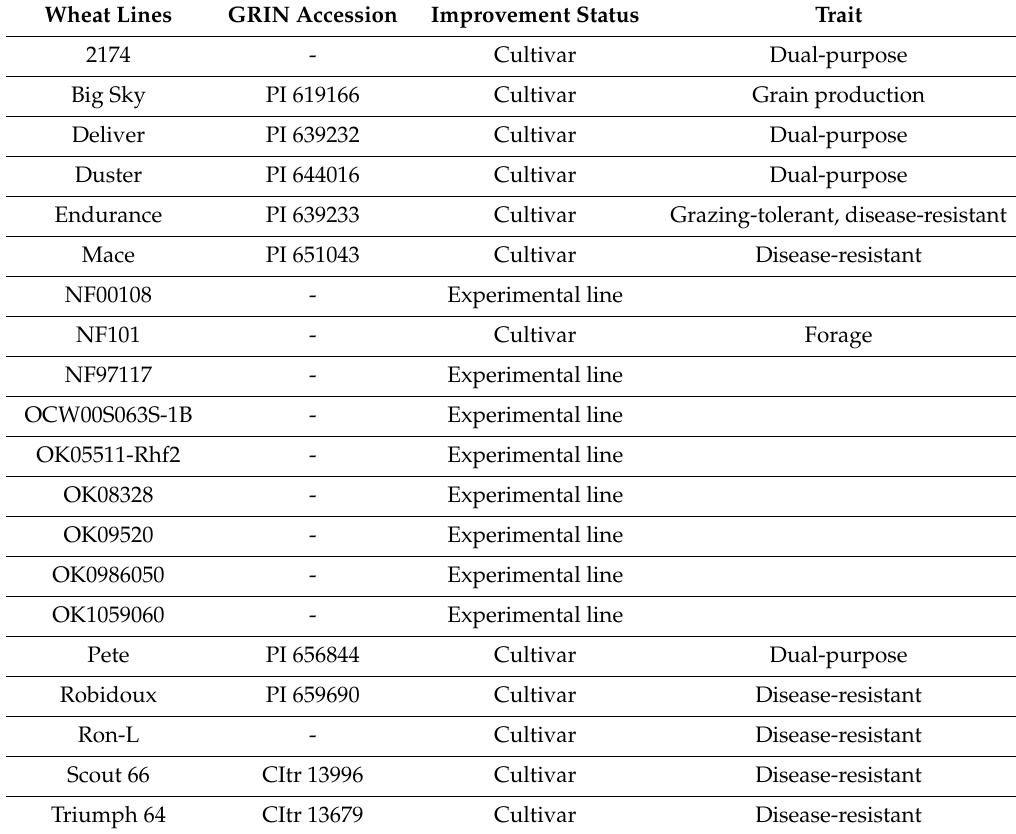
Table 4. Wheat cultivars / lines evaluated in greenhouse and hoop house for nitrogen use e ffi ciency